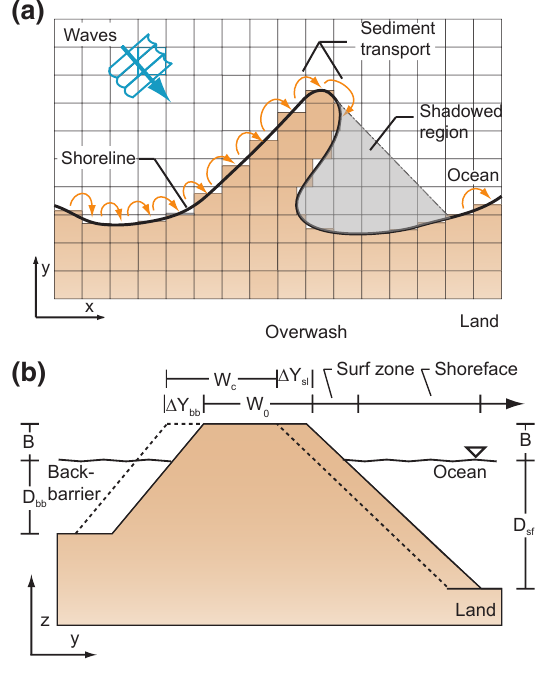
Figure 3. (a) Model schematic of CEM demonstrating discretiza- tion of the plan view into cells. For waves of given orientation and height, sediment is transported along the shoreline based upon the wave angle, and cell quantities are adjusted based on flux gradi- ents. Note also the zone “shadowed” from wave approach: sediment transport does not occur in these shadowed regions. (b) Conceptu- alization of the cross-shore domain with a fixed shape shoreface and barrier overwashing. Alongshore sediment gradients in the surf zone are spread over the shoreface. If the spit width is below the critical width W c , sediment is transported from the front to the back of the